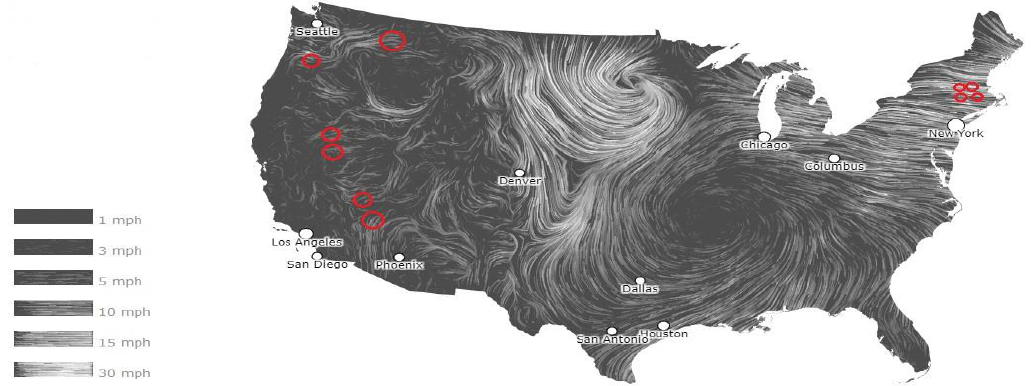
Figure 2. Wind directions in sixteen counties in states of California, Massachusetts, and Washington; and their sixteen neighboring counties in states of Arizona, Connecticut, Idaho, Nevada, New Hampshire, Oregon, Rhode Island, and Vermont.